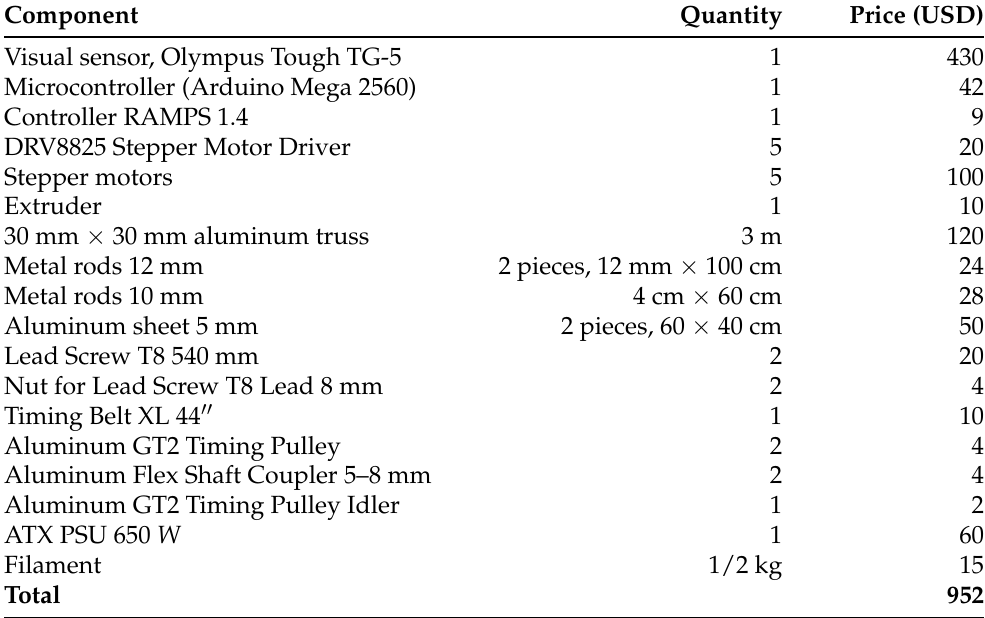
Table 2. Costs of utilized